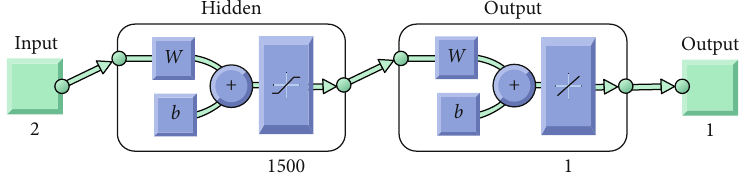
Figure 4: DNN model for PV MPPT system.